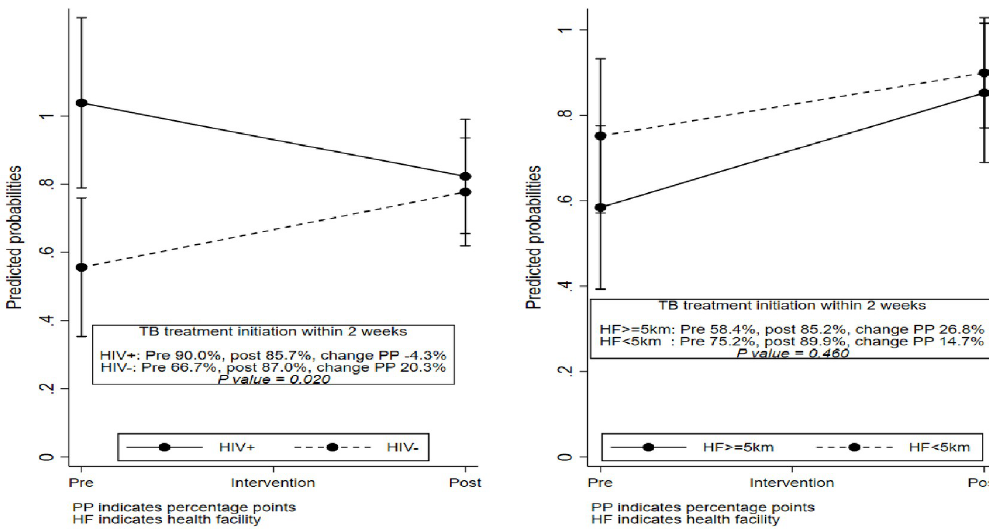
Fig 1. Subgroup analysis: Predicted probabilities of TB treatment initiation within two weeks by HIV status and distance to the health facility. Probabilities predicted after fitting a Poisson regression model (with robust standard errors) with interaction between intervention period and a patient characteristic, adjusting for other patient characteristics: sex, age groups, care entry point, distance to health facility and HIV status.